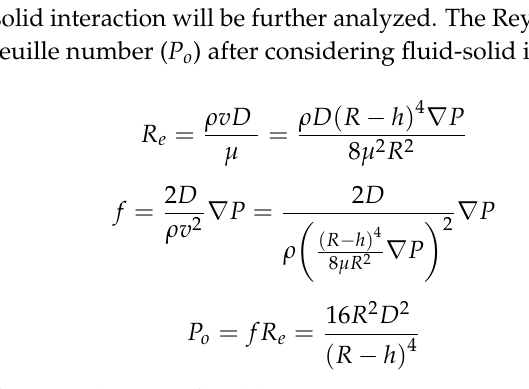
Figure 12. Fluid-solid interaction on average flow velocity under two conditions: ( a ) Average flow velocity versus ∇ P ; ( b ) Average flow velocity versus radius.